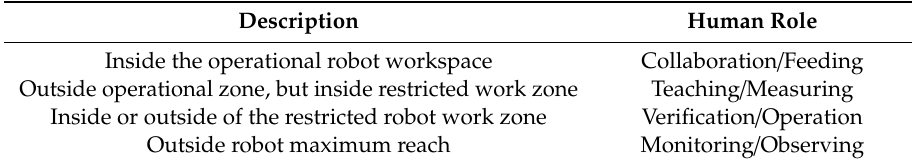
Table 1. Robot-Human interaction levels [39].